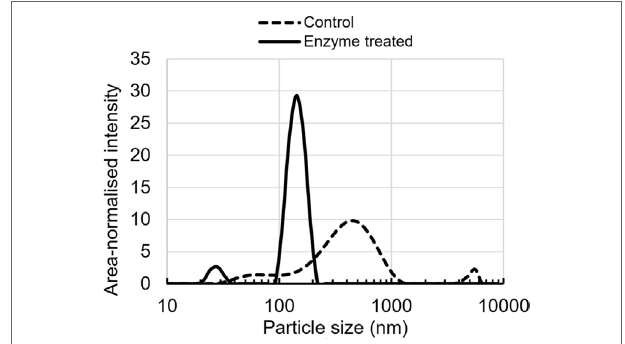
FigUre 4 | Colloidal particle size distribution of enzyme-treated and control lignin in a buffer at pH